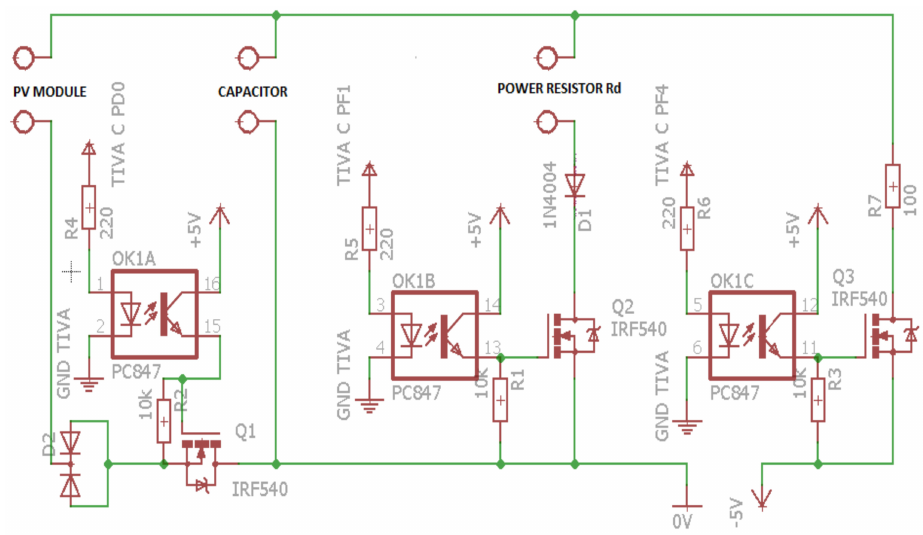
Figure 8. Power stage and symmetrical source for its supply.